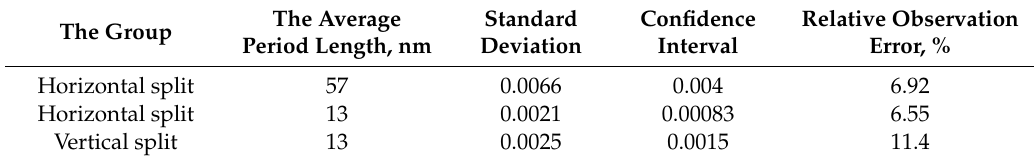
Figure 6. Periodic nanoscale structures of the fractal type. They are registered on the negative wall of a domain structure in a LiNbO 3 :Gd (0.44 wt.%) single crystal. The image was obtained using an SMM-2000 atomic force microscope after intense etching of the sample in a mixture of HF and HNO 3 acids. The figure is reproduced with the permission of Pleiades Publishing, Ltd. from the paper Cryst.